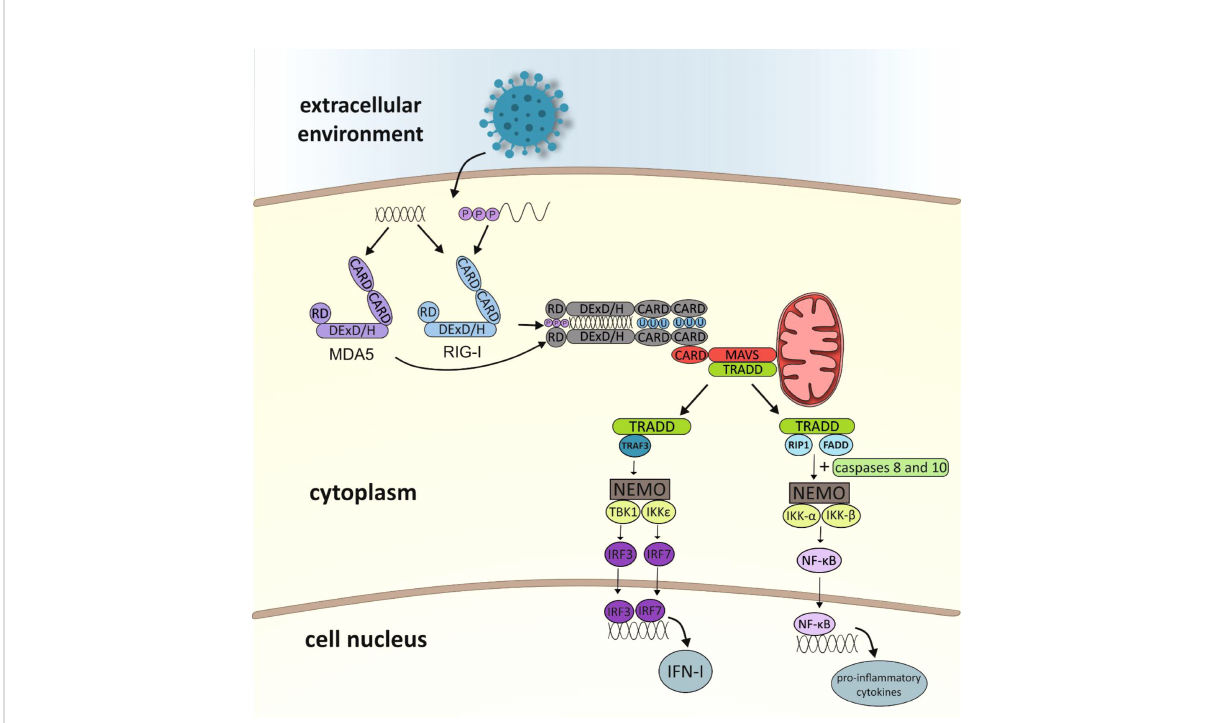
FIGURE 2 Diagram showing activation of the immune response leading to RLR receptor-dependent production of type I interferon and pro-in fl ammatory cytokines (CARD, caspase activation and recruitment domain; RD, repressor/regulatory domain; MDA5, melanoma differentiation associated gene 5; RIG-I, retinoic acid-inducible gene-I; MAVS, mitochondrial antiviral signaling protein; TRADD, TNFR1-associated death domain; TRAF3, TNF receptor-associated factor 3; RIP1, receptor interacting protein 1; FADD, Fas-associated death domain; NEMO, NF- k B essential modulator; NF- k B essential modulator; TBK1, TANK-binding kinase 1; IKK, I k B kinase; IRF, IFN-gene regulatory factor; NF- k B – nuclear factor k B; IFN,